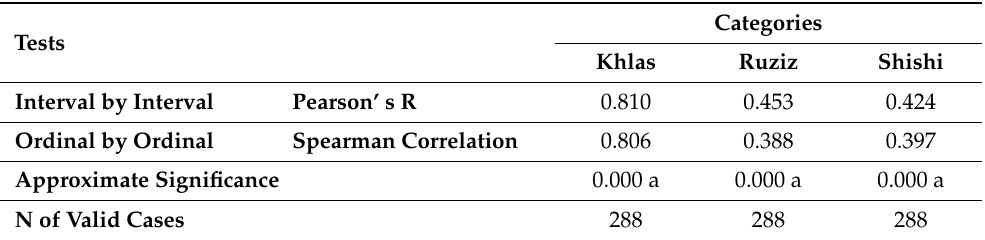
Table 4. Pearson’s R (Interval by Interval) and Spearman (Ordinal by Ordinal) tests for cultivated area versus cultivars’ area